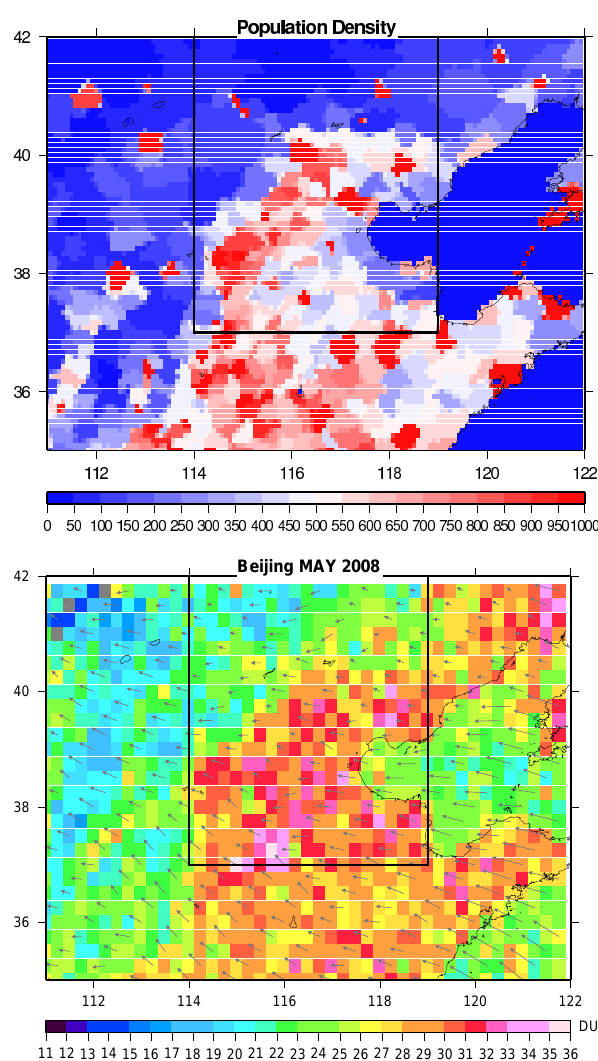
Fig. 9. (a) Population density (in persons per km 2 ) in North China. The Beijing area considered in this study is represented by the black square. (b) Monthly wind field at the surface from ECMWF mete- orological forecasts. The mean 0–6km ozone columns measured during May 2008 are also